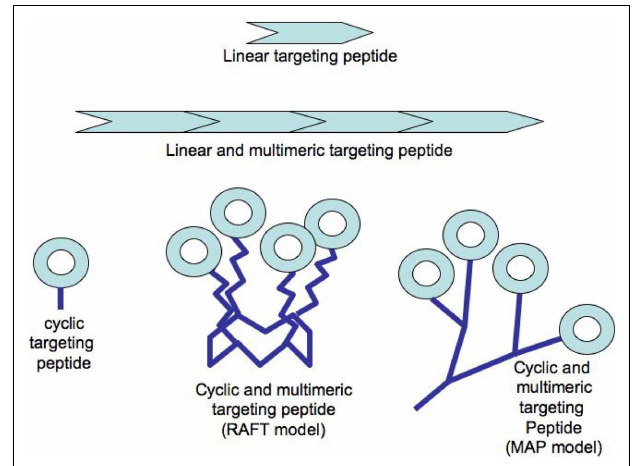
FIGURE 1 | Examples of peptide constructs used in radiotherapy or imaging